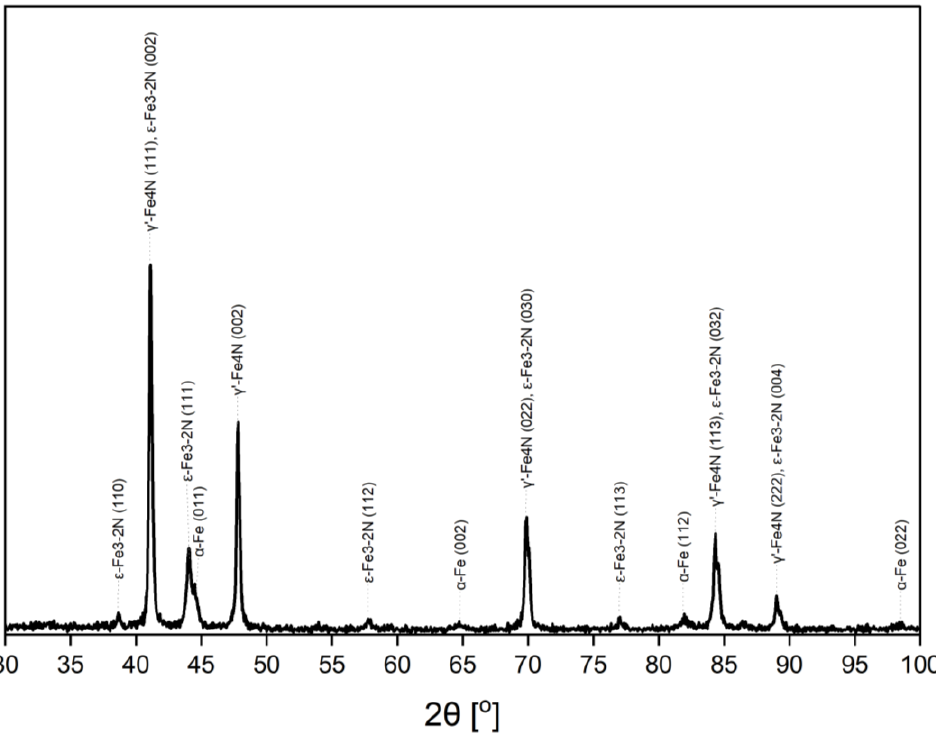
Figure 1. The diffractogram acquired for the gas composition of 45:55 NH 3 :H 2 during denitriding in 350 °C, the example of the coexistence of all phases: α-Fe, γ’-Fe 4 N and ε-Fe 3-2 N identified in the examined sample.